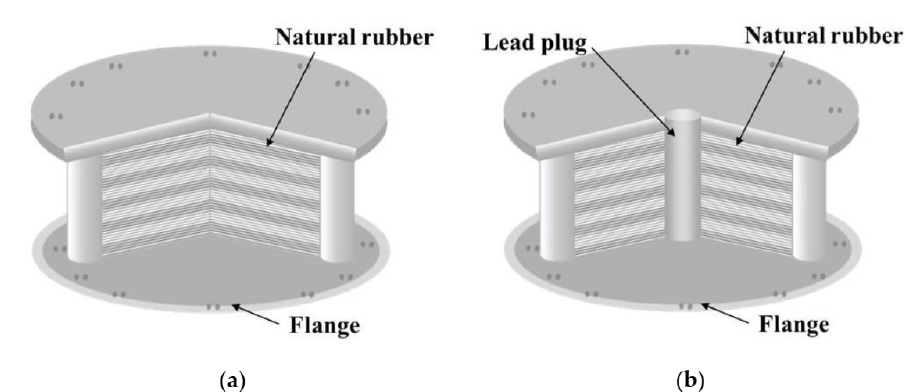
Figure 1. Elastomeric bearings: ( a ) Natural Rubber Bearing (NRB); ( b ) Lead Rubber Bearing